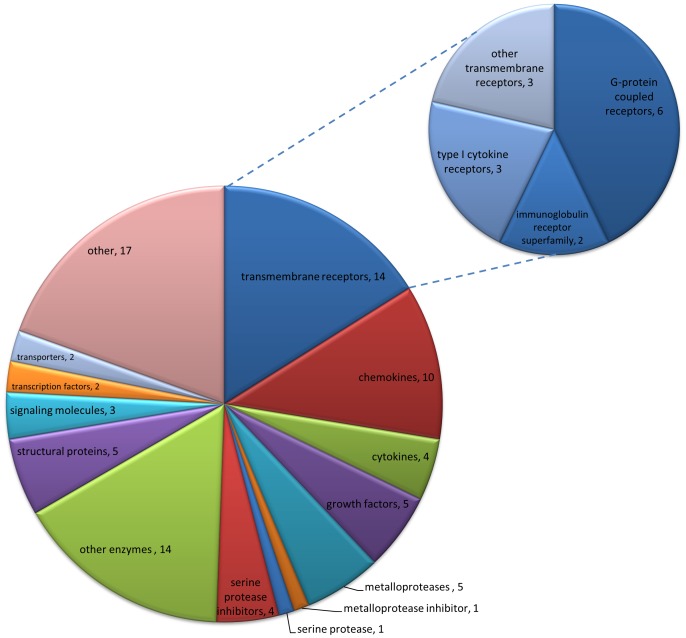
Functional annotation of ‘top hits’.Pie chart with the categorisation of eighty seven genes commonly up-regulated (>4 fold increase in both species, p value <0.05) by “protein category”. Cytokines and chemokines feature prominently (14/87) as well as transmembrane receptors (14/87). Distribution of subcategories of transmembrane receptors is depicted in the small pie chart.